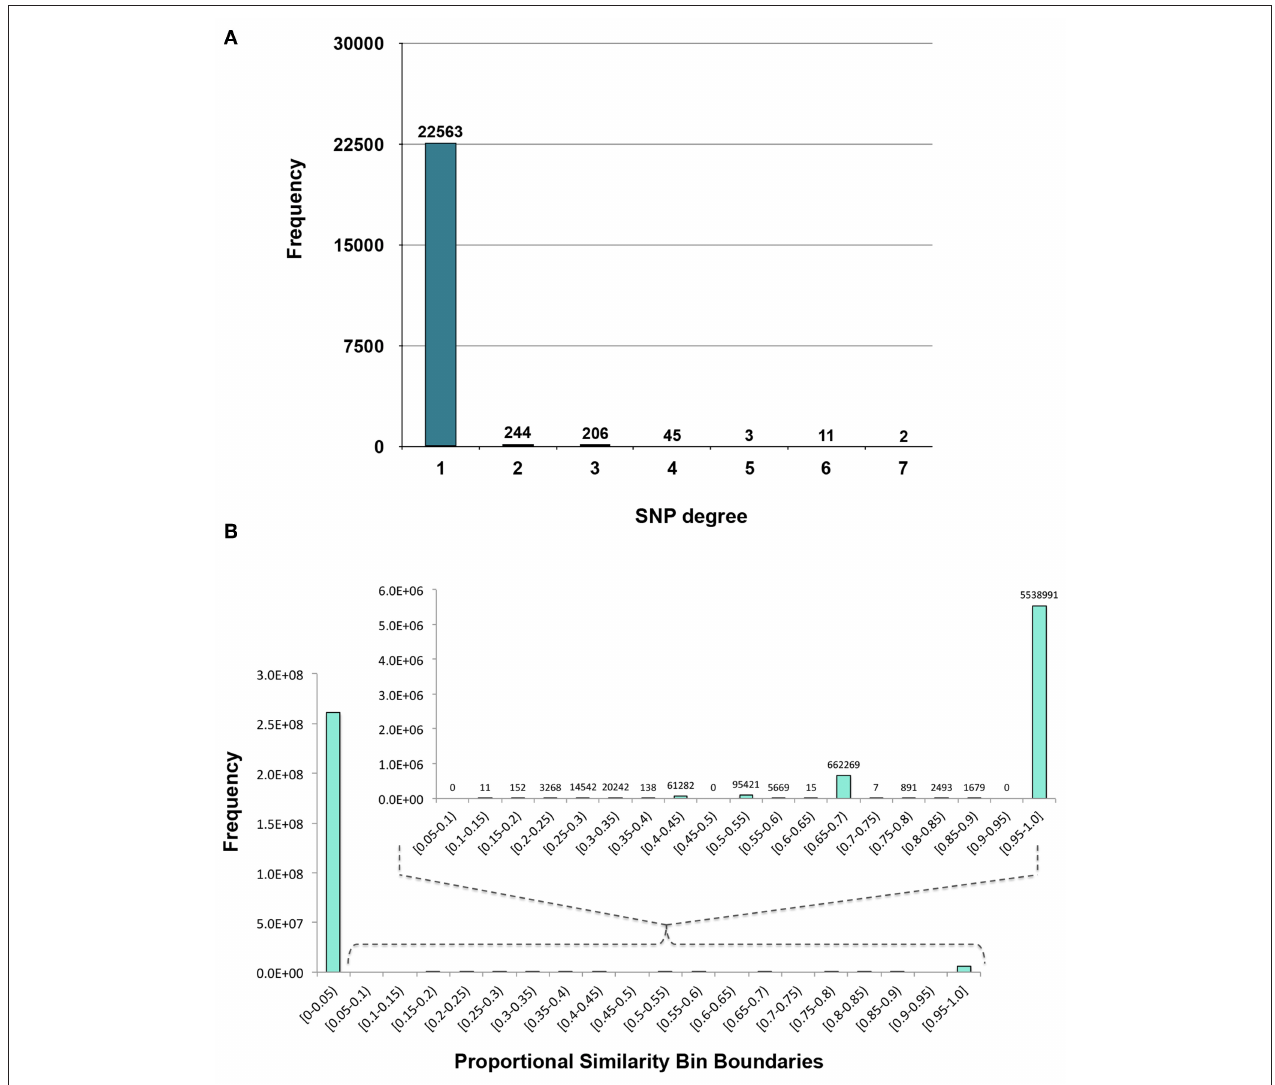
FIGURE 3 | Distributions. (A) Degree distribution of SNP nodes in the SNP-phenotype GWAS bipartite network. (B) Distribution of the Proportional Similarity edge weights in the SNP association